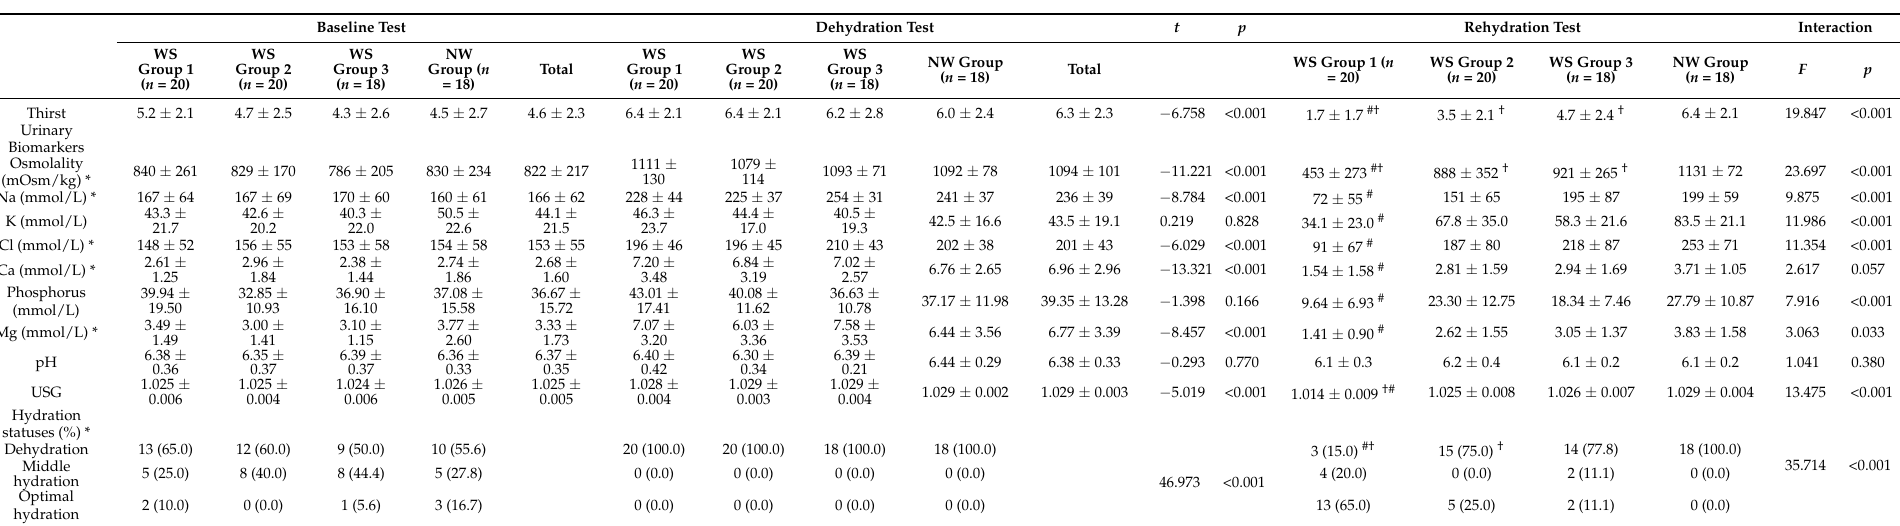
Table 4. The thirst and urine biomarkers of the